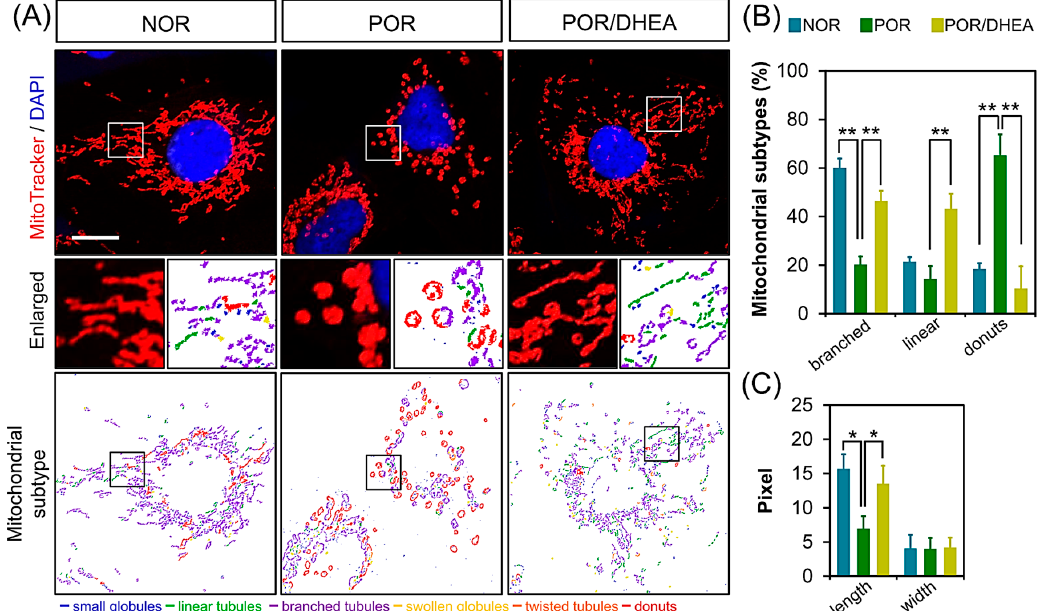
Figure 4. DHEA increased mitochondrial elongation. ( A ) Cumulus cells (CCs) were stained with MitoTracker Red and observed by confocal microscopy to analyze the mitochondrial network structure. MicroP software classifies mitochondria in each cell into three categories according to the features of mitochondrial morphology. ( B ) Three major types of mitochondria were quantified: globular, tubular, and branched, as well as their total length and width. ( B , C ) The proportions of different categories of mitochondria obtained from various treatments are shown in ( B ), and the changes in length and width of the mitochondria are shown in ( C ). Data represented the mean ± SEM of 3–5 independent experiments. * p < 0.05, ** p < 0.01. Scale bar: 20 µ